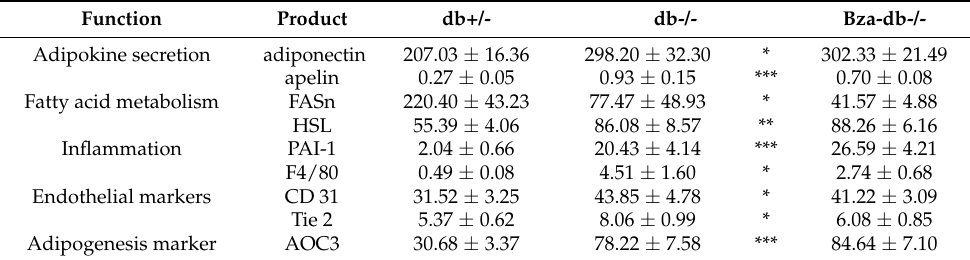
Table 4. Altered gene expressions in SCWAT from obese mice that were not improved by oral